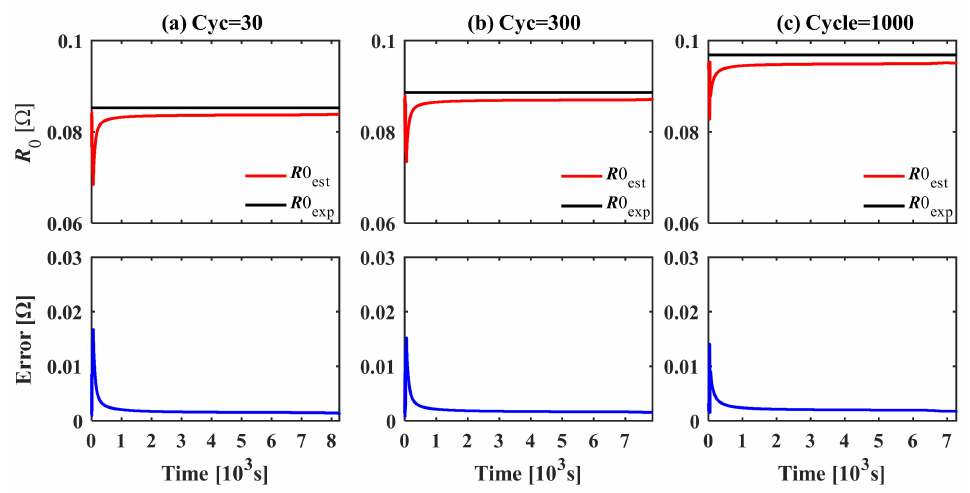
Figure 11. R 0 estimation results and errors at ( a ) Cyc = 30, ( b ) Cyc = 300 and ( c ) Cyc = 1000 under CCC test profile.